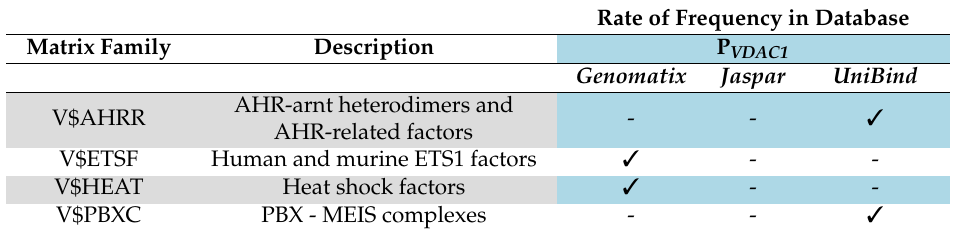
Table 2. VDAC1 unique Transcription Factor Binding Sites(TFBSs). The sign (cid:51) indicates the presence of the TFBS in P VDAC1 sequence selected by a specific